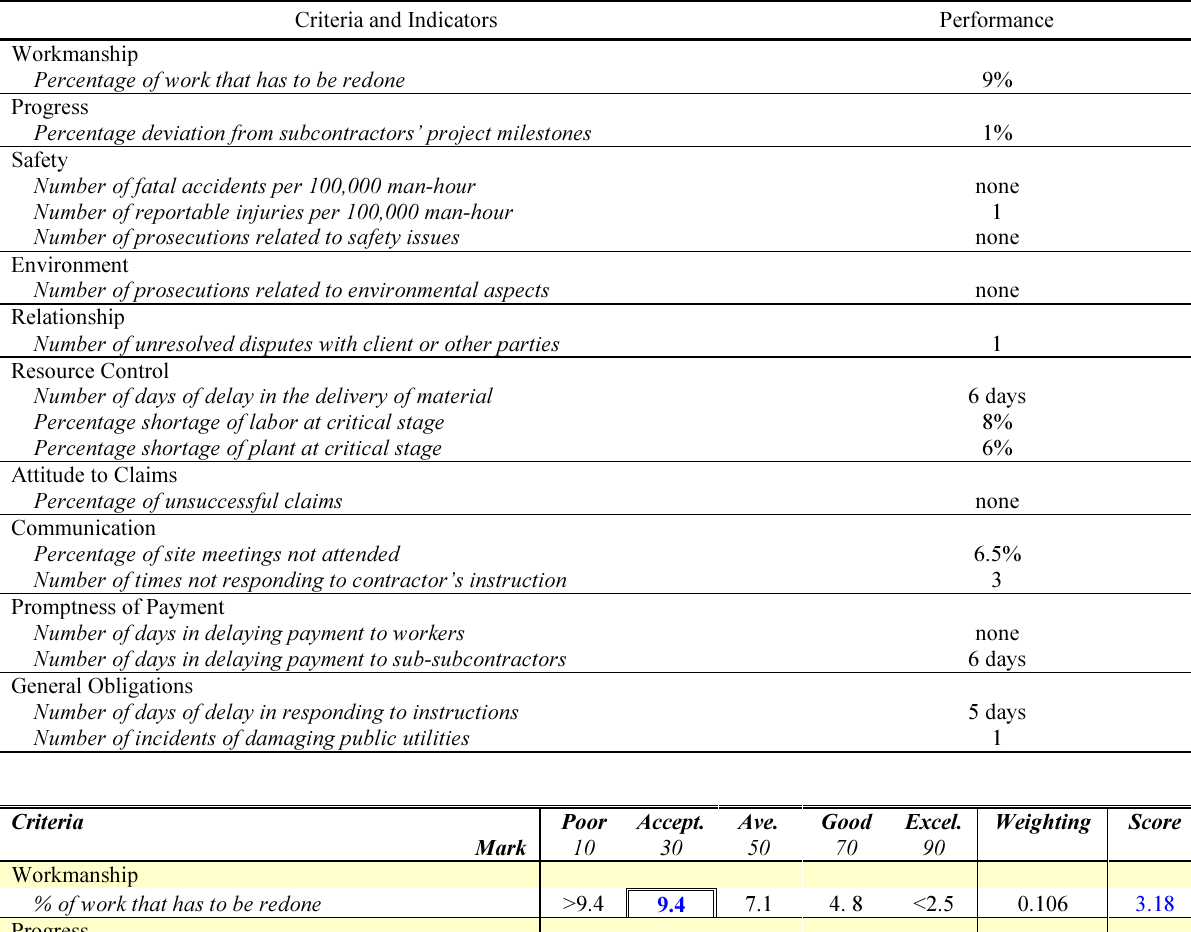
Table 3. Actual performance of a subcontractor in a project Criteria and Indicators